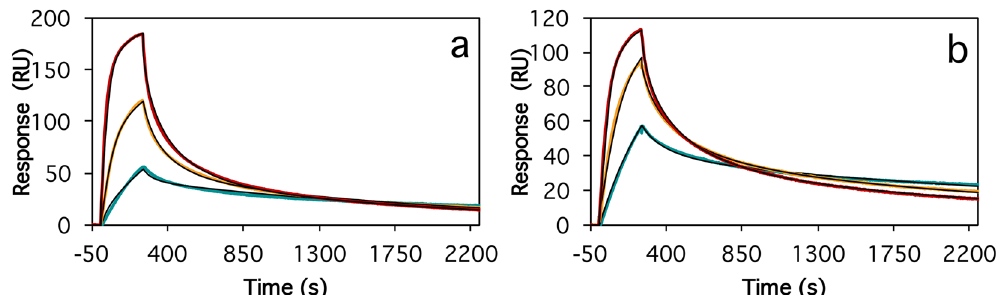
Figure 4. Association and dissociation kinetics for binding of two representative monomeric Affibody constructs to immobilized A β 42 cc protofibrils. Affibody concentrations are 10 (green), 20 (yellow) and 40 nM (red). The data was fitted to a heterogeneous ligand binding model with local maximum response (R max ) values. The kinetics of the slow association and dissociation phases are k a = 2.8 ( ± 0.1) × 10 5 s − 1 M − 1 and k a = 2.5 ( ± 0.1) × 10 5 s − 1 M − 1 and k d = 4.7 ( ± 0.05) × 10 − 4 s − 1 and k d = 6.2 ( ± 0.05) × 10 − 4 s − 1 for Z A β 42cc_1 ( a ) and Z A β 42cc_4 ( b ), respectively, which correspond to dissociation constants for the stronger binding site of K D = 1.6 ( ± 0.1) and K D = 2.5 ( ± 0.2) nM,